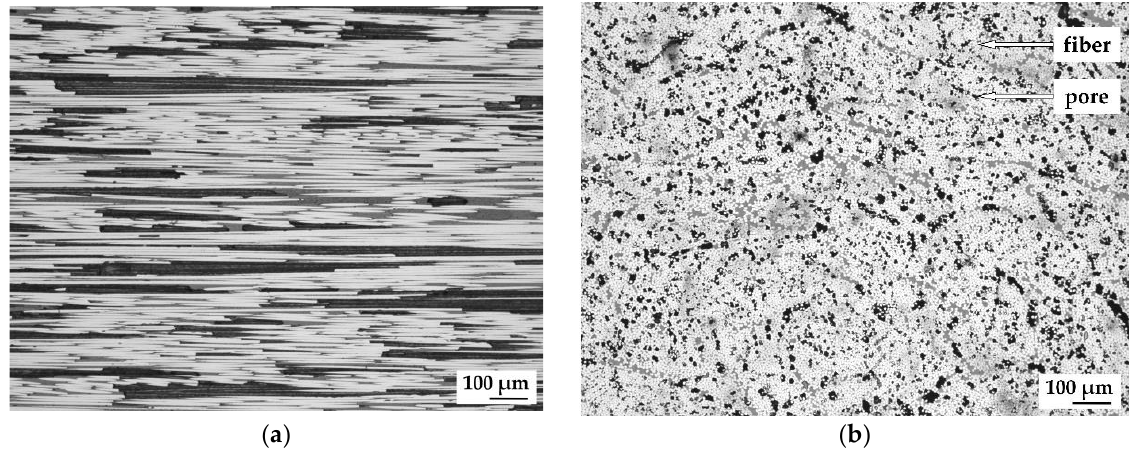
Figure 6. Microstructure of the CFRP composite (light microscopy, bright field): ( a ) longitudinal section; ( b ) cross section (light color: fiber areas; dark color: pores).